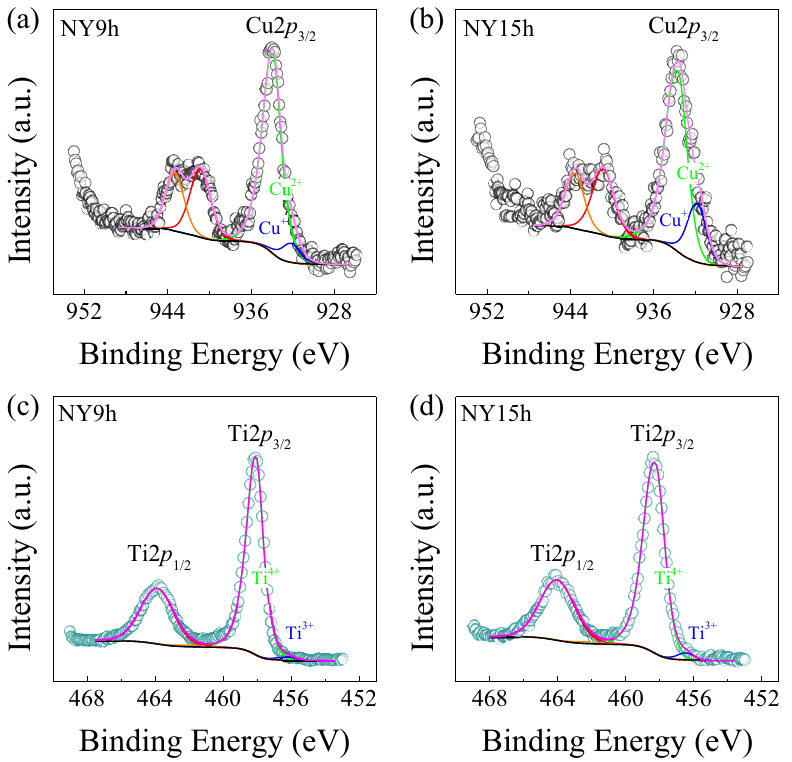
Figure 11. ( a , b ) XPS Cu2 p spectra of NY9h and NY15h ceramics. ( c , d ) XPS Ti2 p spectra of these two